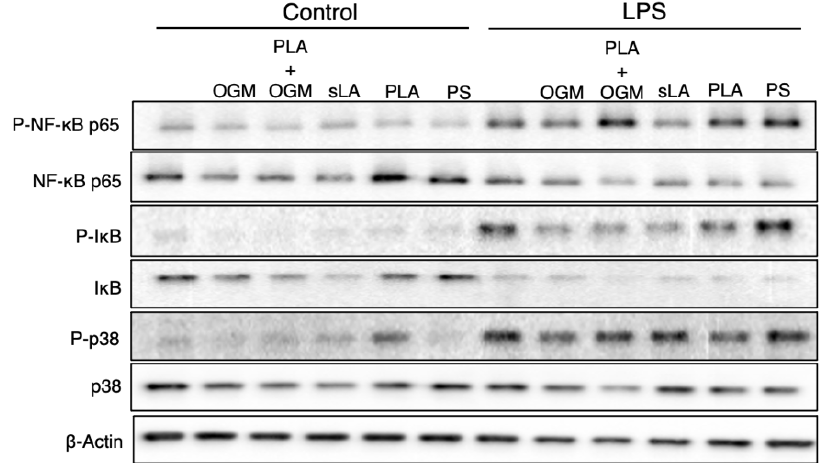
Figure 7. GPR68 inhibition with OGM reverses lactate-mediated suppression of NF- κ B p65 activation. BMM Φ cells were treated like previously with soluble lactic acid (sLA) or nanoparticles composed of PLA-PEMA (PLA) or polystyrene-COOH (PS). The addition of OGM, a GPR68 inhibitor, reverses the inhibition of p65 activation seen with PLA following particle incubation and 1-hr LPS stimulation. Samples were immunoblotted for phospho-NF- κ B p65 (Ser536), total NF- κ B p65, phospho-I κ B (Ser32), total I κ B, phospho-p38 (Thr180/Tyr182), total p38, and β -actin.